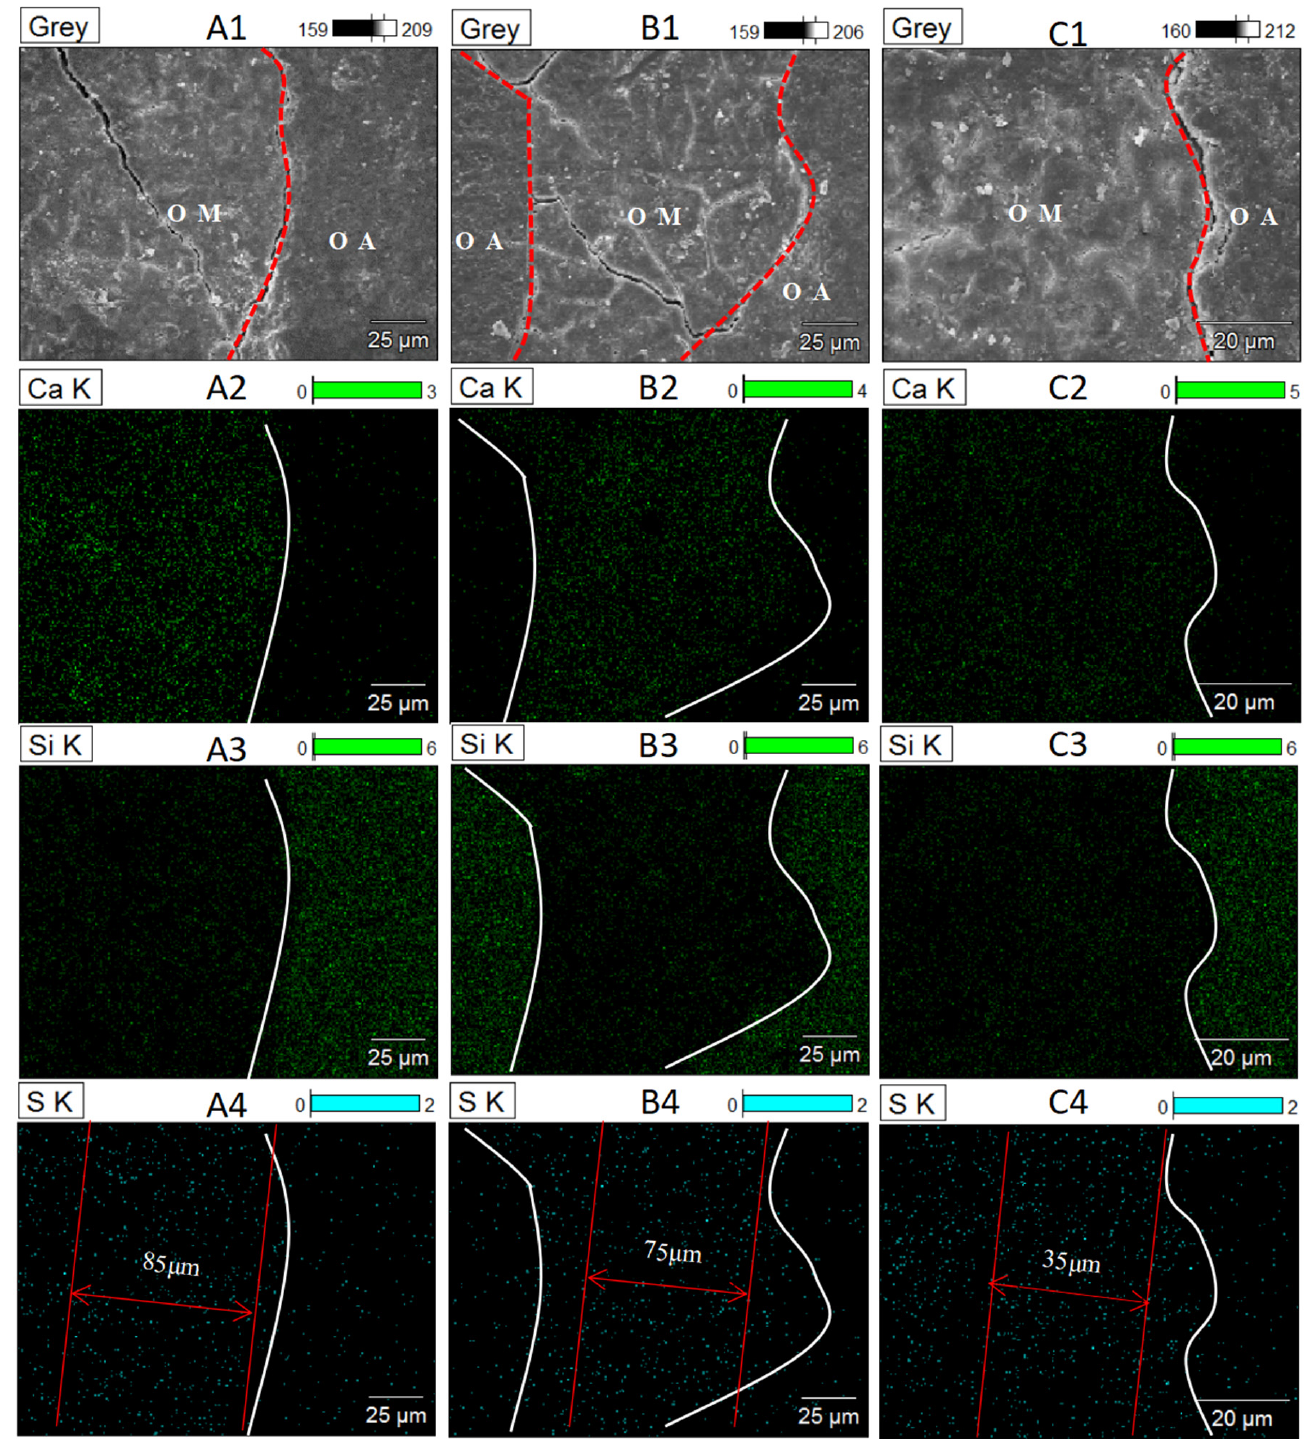
Figure 13. Surface features and the corresponding elemental mapping of OA-OM-ITZ after SO 42 − attack: ( A 1 – A 4 ) S-RCA recycled concrete, ( B 1 – B 4 ) C-RCA recycled concrete, ( C 1 – C 4 ) Si-RCA recycled concrete.